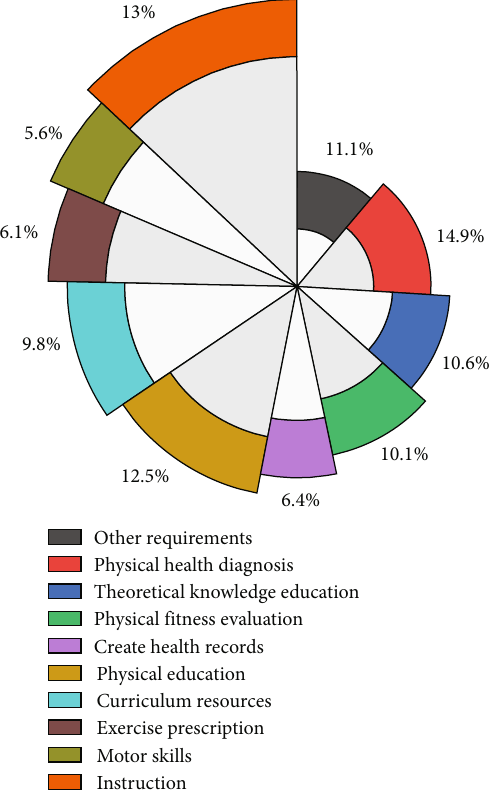
Figure 3: Students ’ demands for the functions of the physical fi tness test data platform for college